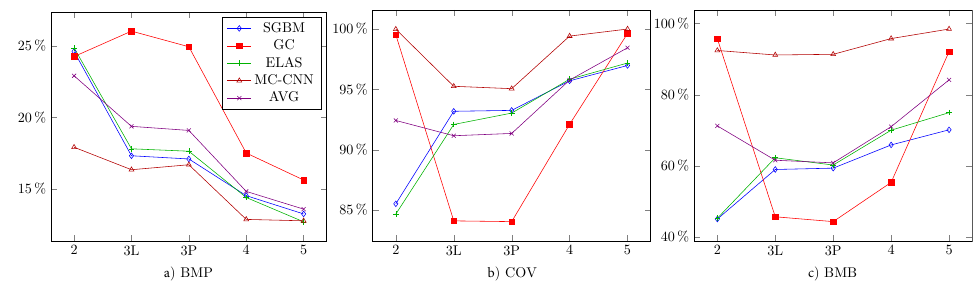
Figure 12. Results obtained for EEMM used with different number of cameras. The figure presents values of the following quality metrics: ( a ) BMP, ( b ) COV and ( c ) BMB.